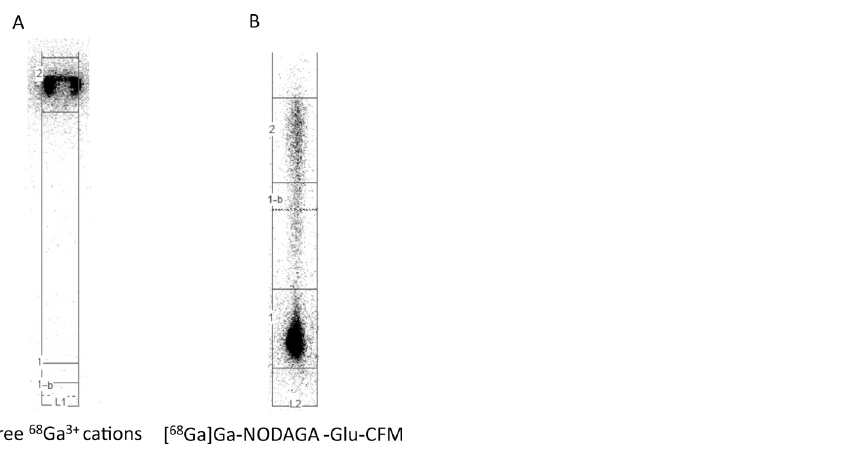
Figure 9. ITLC analyses of free 68 Ga 3+ ( A ) and the reaction mixture after synthesis of the [ 68 Ga]Ga- NODAGA-Glu-CFM radioconjugate ( B ) using citrate bu ff er as a developing solvent.